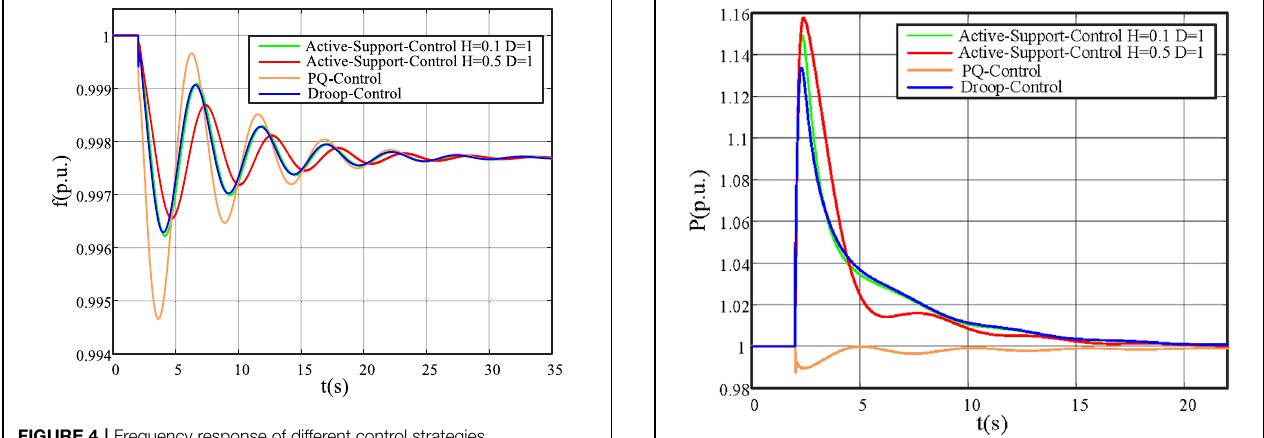
FIGURE 4 | Frequency response of different control strategies.